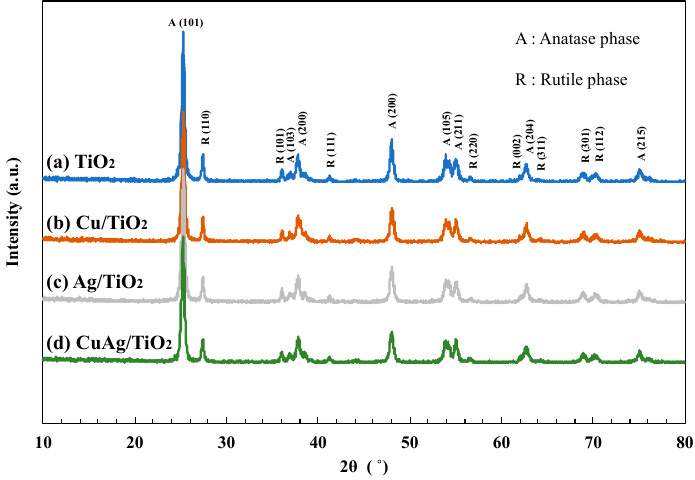
Figure 1. XRD spectra of ( a ) TiO 2 P25, ( b ) Cu / TiO 2 , ( c ) Ag / TiO 2 and ( d ) CuAg / TiO 2 .